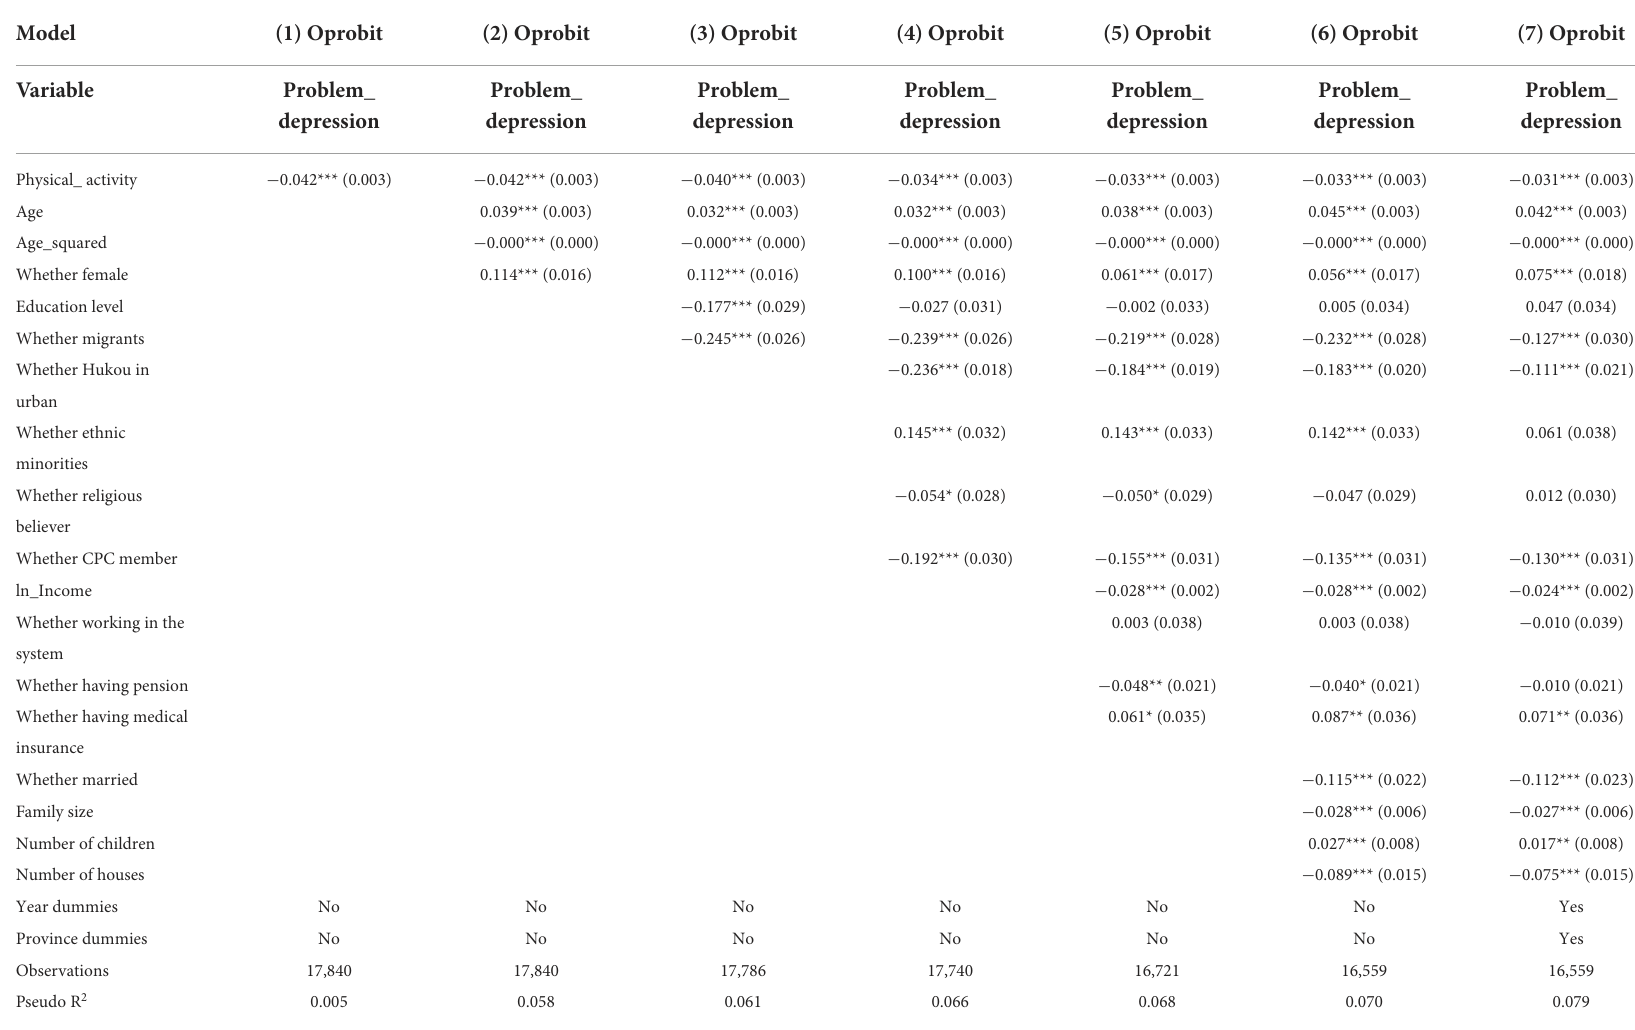
TABLE 1 Benchmark regression